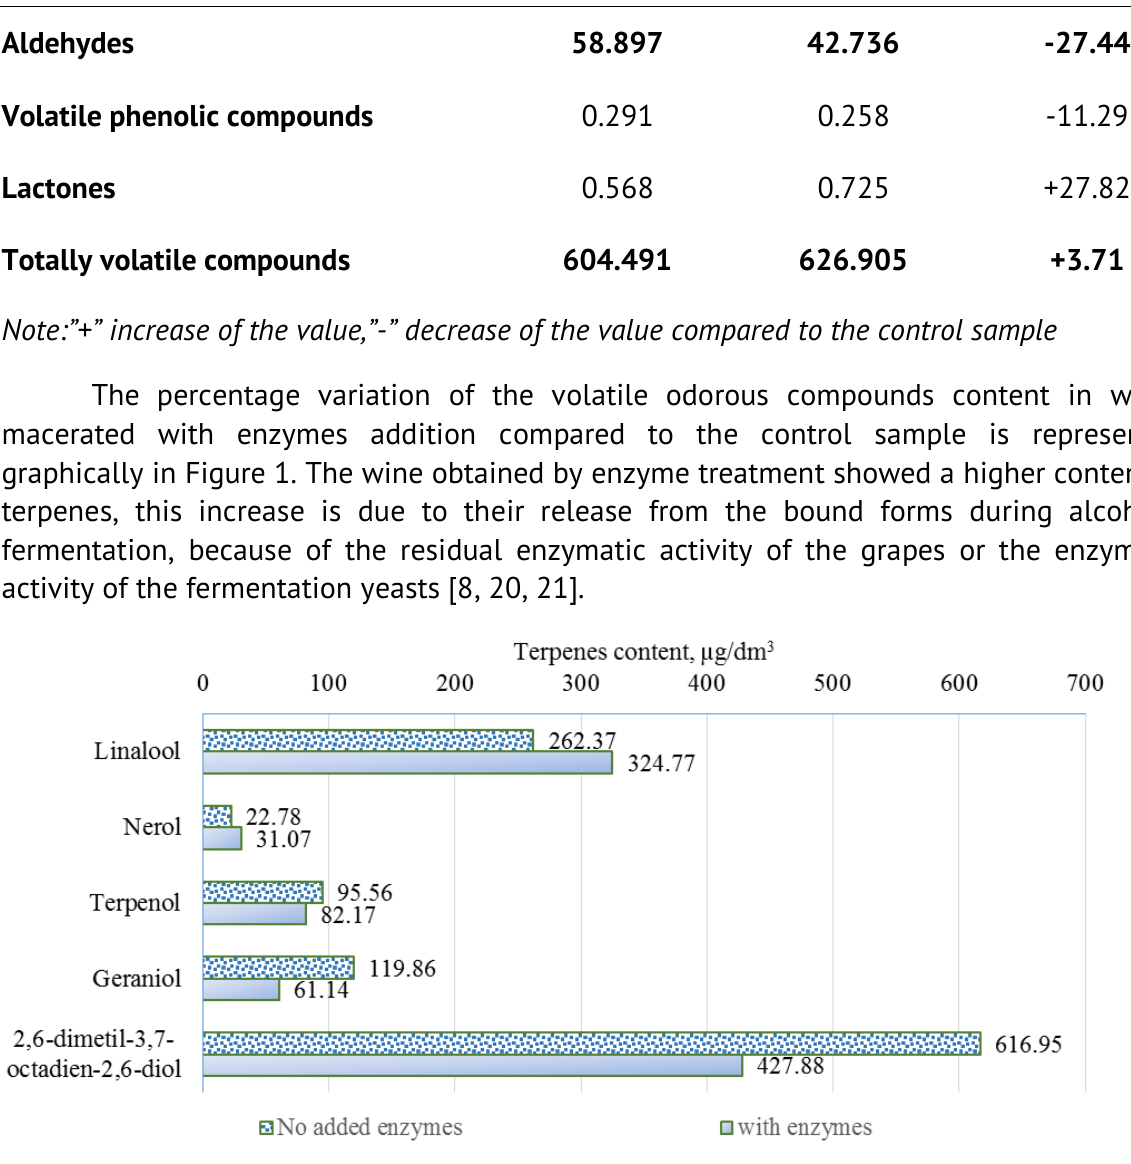
Figure 1. Influence of the enzyme addition on the content of the most important terpenes. Cyclization of nerol, geraniol and linalool in an acid medium gives α -terpineol